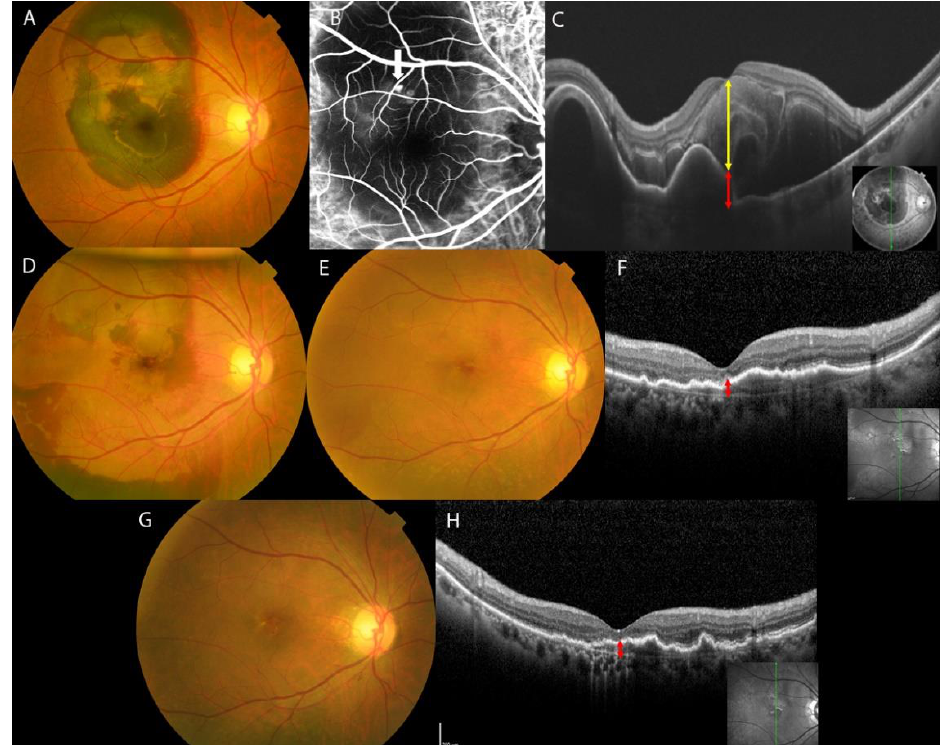
Figure 2. Image findings during the clinical course of a 64-year-old man with submacular hemorrhage secondary to polypoidal choroidal vasculopathy treated with intravitreal tissue plasminogen activator, ranibizumab and gas injections. Duration from onset to treatment was 2 days. ( A ) Before treatment, color fundus photograph shows submacular hemorrhage measuring 7 disc diameters involving the fovea. ( B ) Pretreatment indocyanine green angiography shows a polypoidal lesion (arrow). ( C ) Before treatment (ETDRS score 37 letters), optical coherence tomographic (OCT) shows central retinal thickness (CRT) of 795 μm (yellow up - down arrow) and CPEDT of 348 μm (red up - down arrow). ( D ) At 1 week after treatment, complete displacement of the submacular hemorrhage is confirmed. ( E ) At 3 months after treatment, the submacular hemorrhage has disappeared. ( F ) At 3 months after treatment (ETDRS score 77 letters), OCT image shows CRT of 116 μm and CPEDT of 70 μm. ( G ) At 12 months after treatment, fundus photograph shows no recurrence of submacular hemorrhage. ( H ) At 12 months after treatment (ETDRS score 51 letters), OCT image shows CRT of 111 μm and CPEDT of 79 μm. In this case, pigment epithelial detachment under the fovea was present before and after treatment, resulting in only mild ETDRS improvement. The central ellipsoid zone was not visible. ETDRS: Early Treatment Diabetic Retinopathy Study, CPEDT: central pigment epithelial detachment thickness.